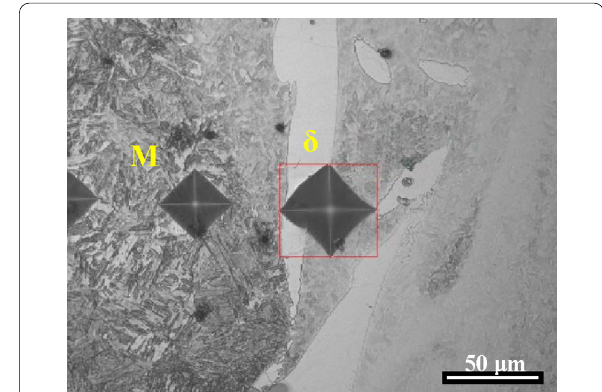
Figure 14 Local hardness indentation near to fusion line of A osc